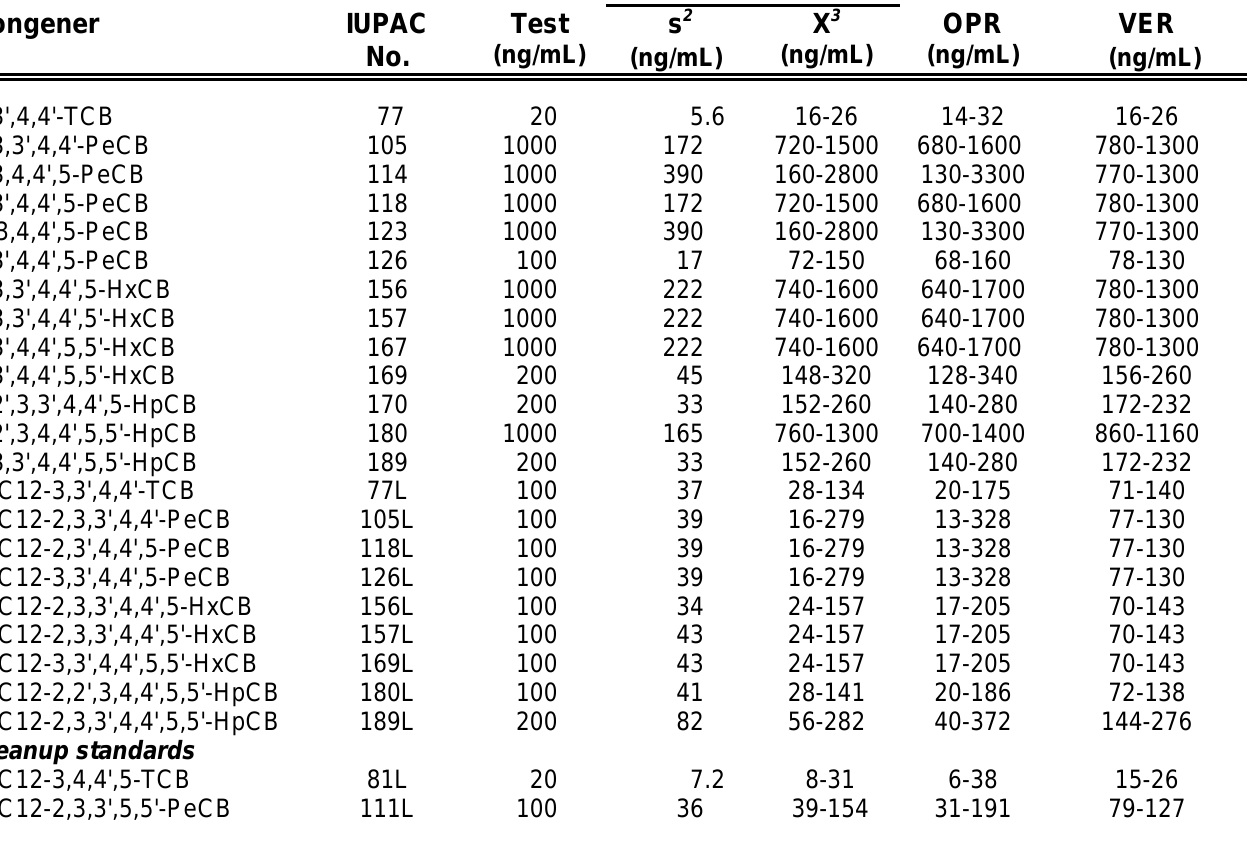
Table 6. Preliminary Acceptance Criteria for Performance Tests When All Toxic PCBs are Tested